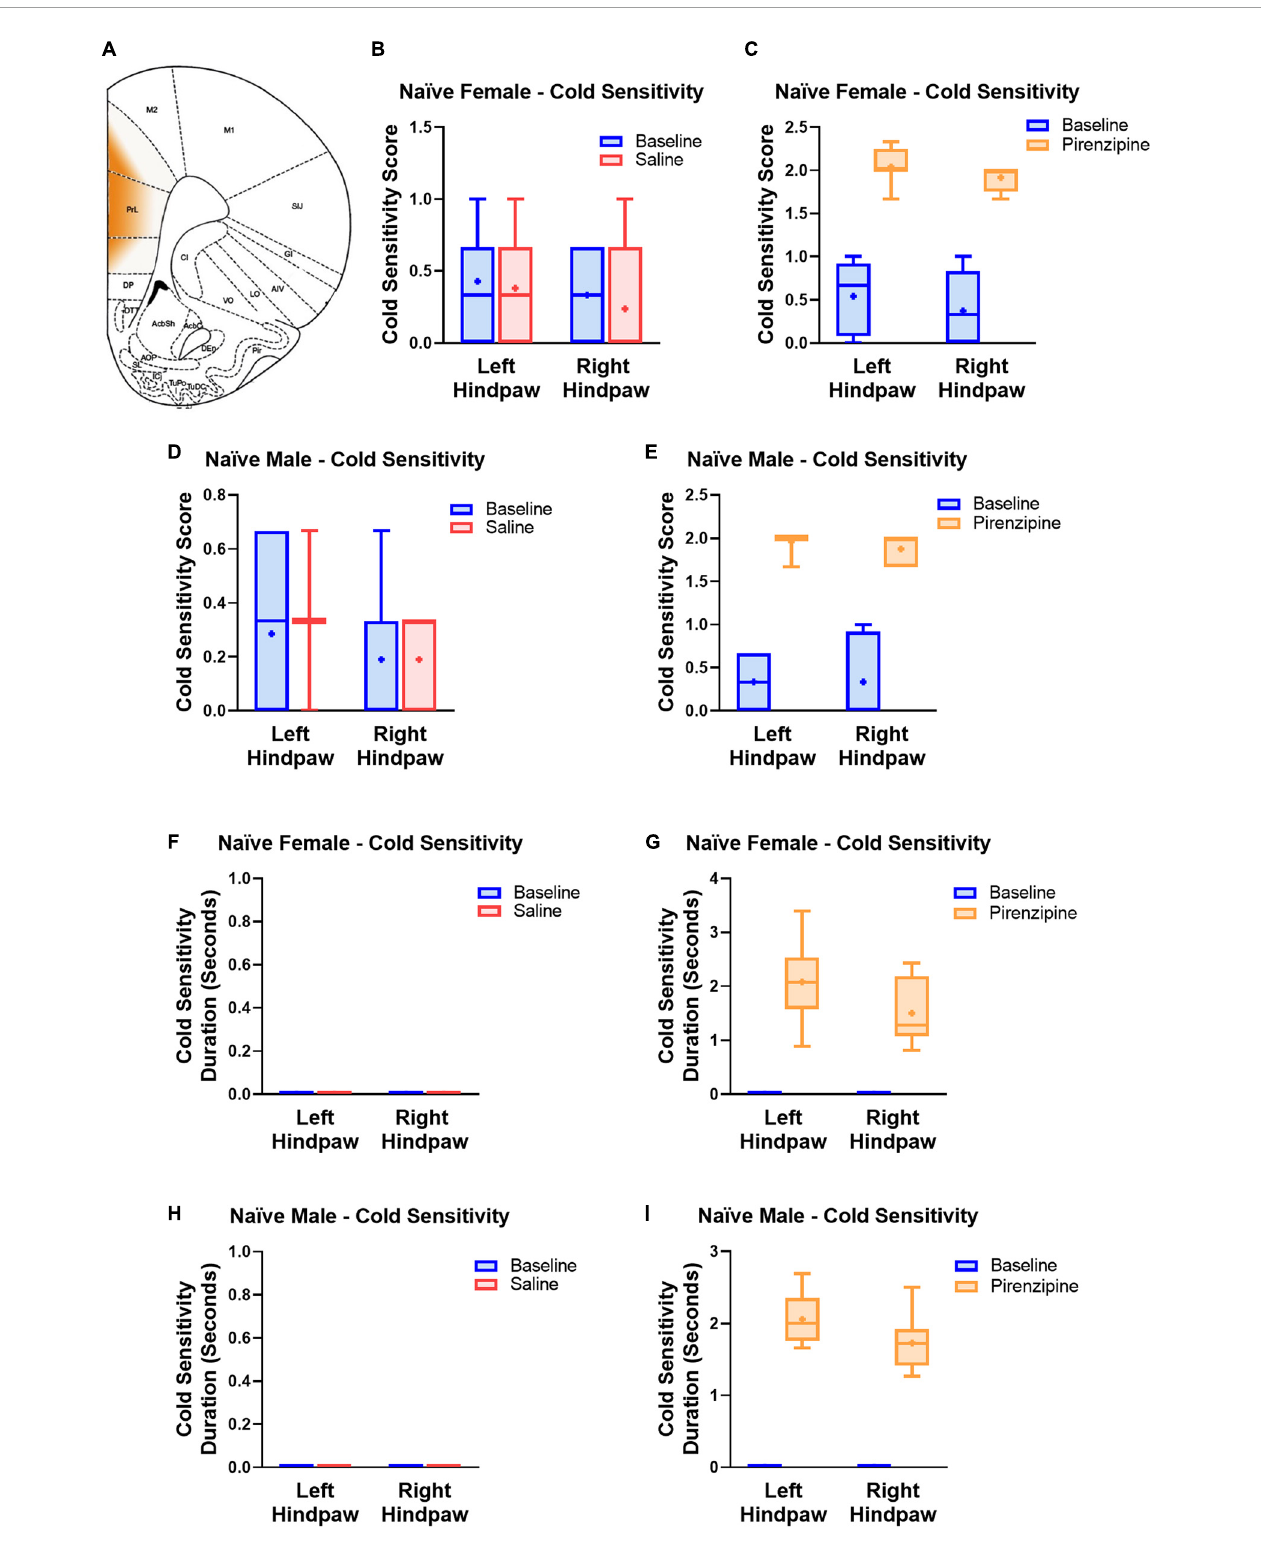
FIGURE5 Selective pharmacological M1 blockade induces cold sensitivity in both males and females. (A) Schematic representing the cortical area where the drug was infused. Responses to the acetone test were quantified using a response score (top, B–E) and response duration (bottom, F–I) . Animals were first tested at baseline (blue bars) and 30 min later infused with 1 µ l of either saline (7 male and 7 female control animals, red bars, B,D,F,H ) or pirenzepine (2.5 nanomoles; experimental group, 8 male and 8 female rats, yellow bars, C,E,G,I ) and re-tested. Note the pro-algesic effect of pirenzepine infusion in both males (8 rats) and females (8 rats). Statistical analysis using paired t -tests yielded the following p -values: Female Score Saline: LP = 0.6036; RP = 0.3559 ( n = 7); Female Score pirenzepine: LP = 0.0001; RP = < 0.0001 ( n = 8); Male Score Saline: LP = 0.6036; RP = > 0.9999 ( n = 7); Male Score pirenzepine: LP = < 0.0001; RP = 0.0001 ( n = 8); Female Duration Saline: n/a; Female Duration pirenzepine: LP = < 0.0001; RP = 0.0002; Male Duration Saline: n/a; Male Duration pirenzepine: LP = < 0.0001; RP = < 0.0001. RP and LP indicate tests on the right and left hind paw, respectively. Data points are aligned in a single file fashion. Consequently, dots with similar value are